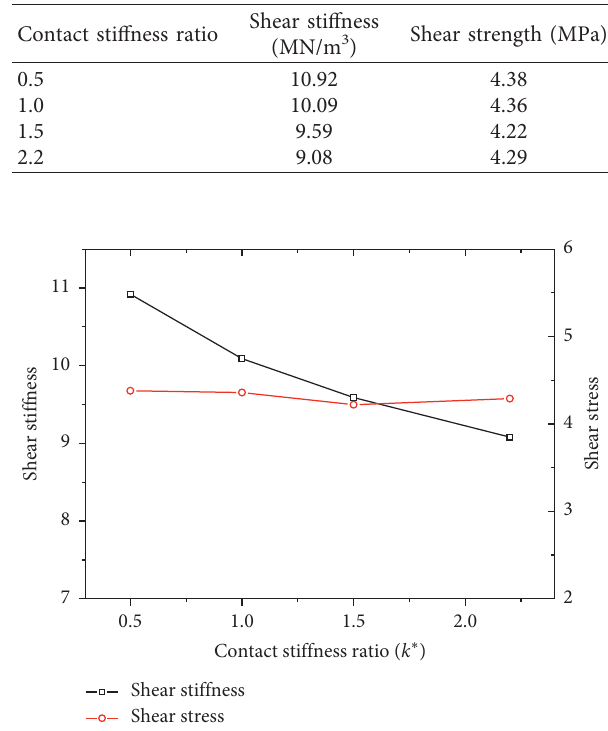
Figure 5: Relationship between contact stiffness ratio and shear